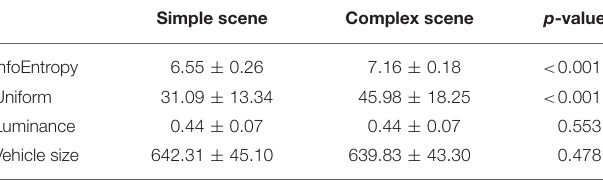
TABLE 1 | Quantitative indicators of stimulus patches.